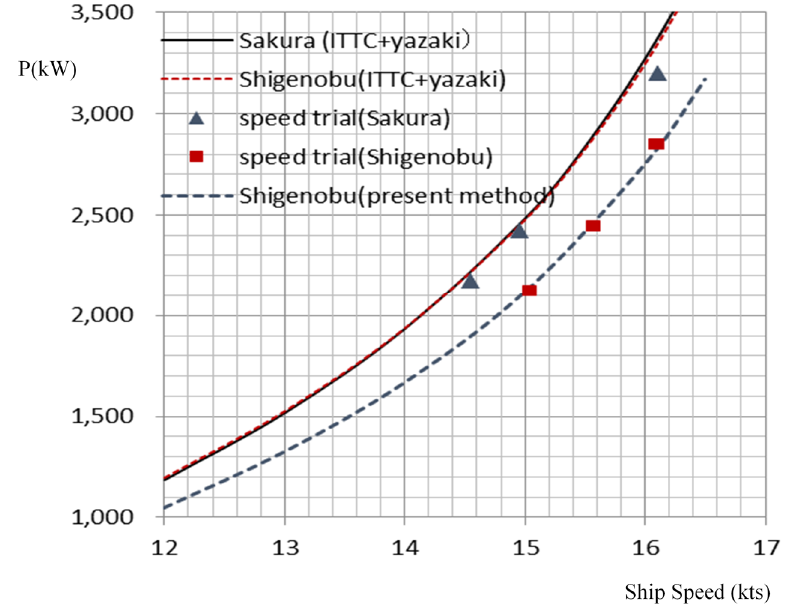
Figure 16. Comparison of trial power predictions for two ships using the ITTC and enhanced method for the gate rudder system.